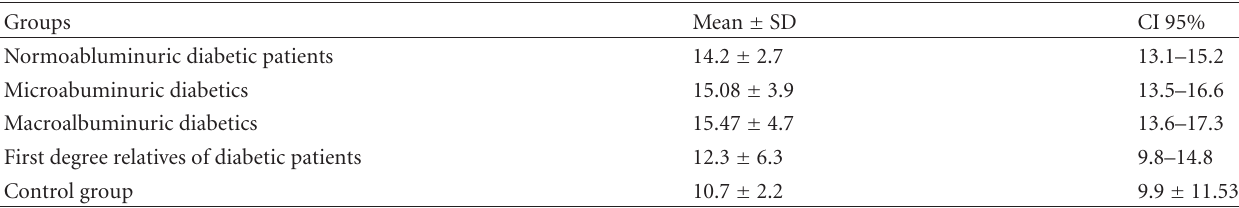
Table 2: Mean and standard deviation of ox-LDL concentration in the five groups of the study.